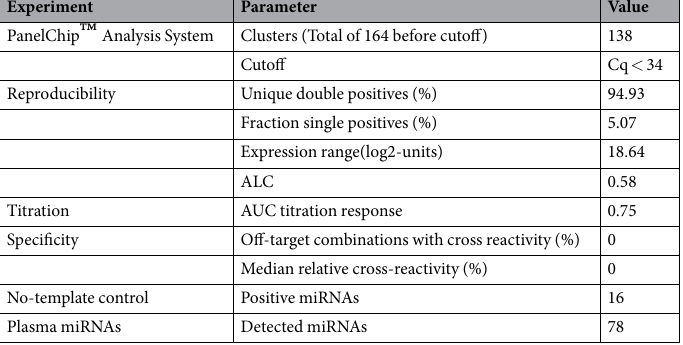
Table 1. Summary of miRQC performance parameters of PanelChip ™ Analysis System. PanelChip ™ Analysis System was evaluated on parameters including reproducibility, titration, specificity, no-template control, detection of plasma miRNAs and differential expression. Clusters, total number of miRNA assays on miRSCan ™ PanCancer Chip 1&2. Cutoff, miRNA assays with Cq value of more than 34 were removed. Reproducibility, the ability to detect the same number of miRNAs in two replicates. Unique double positives, % of miRNAs detected in replicates. Fraction single positives, % of miRNAs detected in one of the two replicates. Expression range, detectable expression range of unique double positives. ALC, area left of cumulative distribution curve where lower ALC is indicative of higher reproducibility. Titration, the ability to correctly predict the order of miRQC A, B, C, and D based on miRNA expression. AUC, area under the curve which is a single scale-invariant measure of platform titration response. Specificity, the specificity of miRNA primers. No- template control, MS2 Phage RNA only. Plasma miRNAs, total number of miRNAs detectable by the platform.